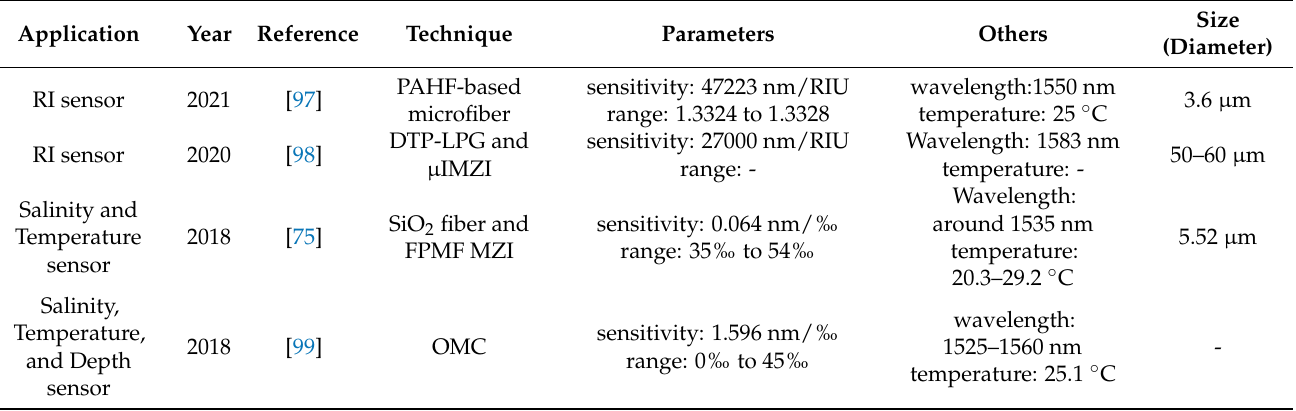
Table 8. Summary of